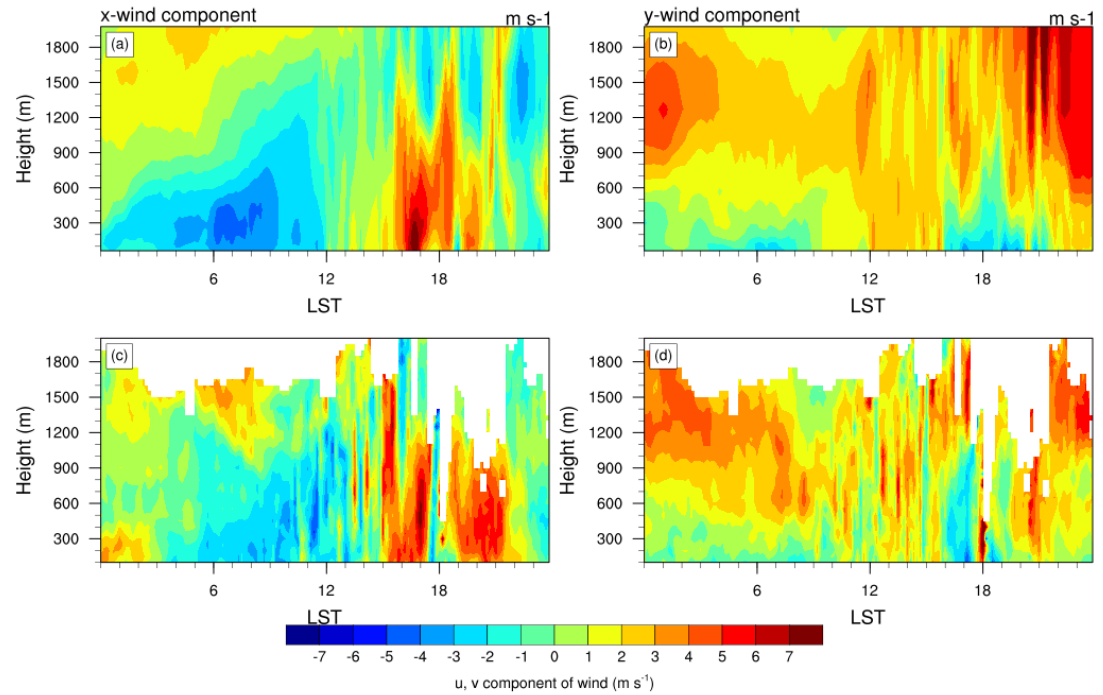
Figure 5. The time–height cross-section of u -component of wind for ( a ) CNTL simulation and ( c ) observation, v -component of wind for ( b ) CNTL simulation, and ( d ) observation measured by wind lidar at Gwanghwamun site from 0000 to 2400 LST on 6 July 2017.